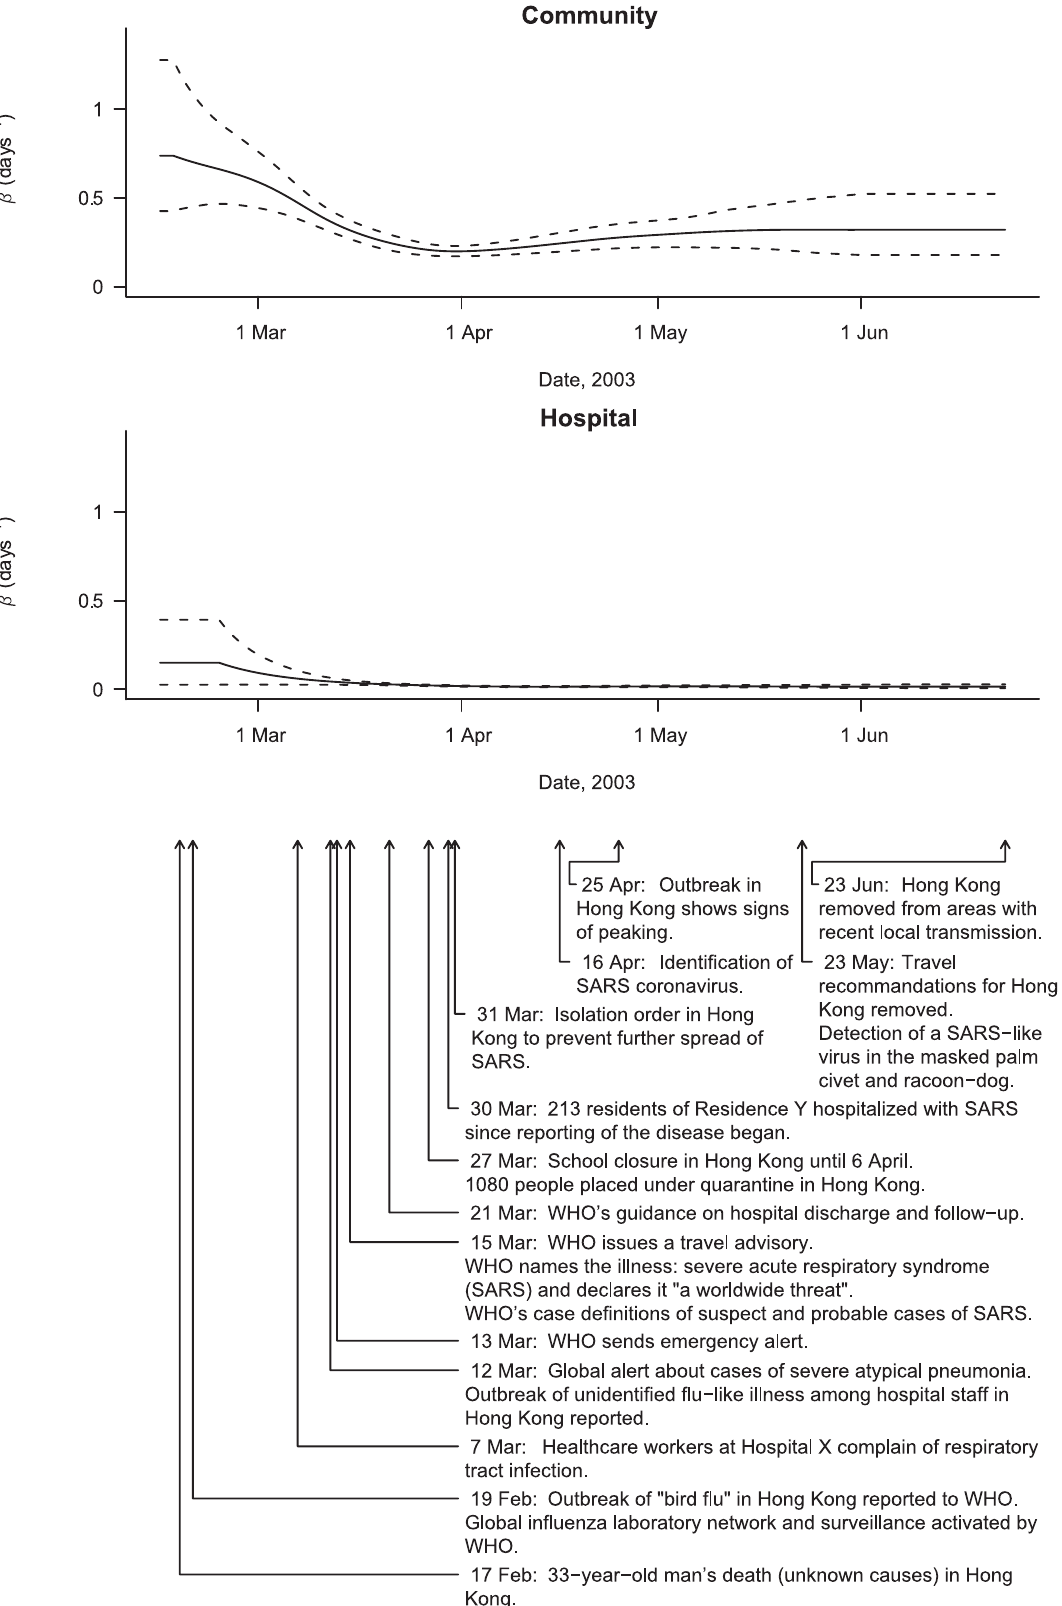
PLoS Computational Biology |